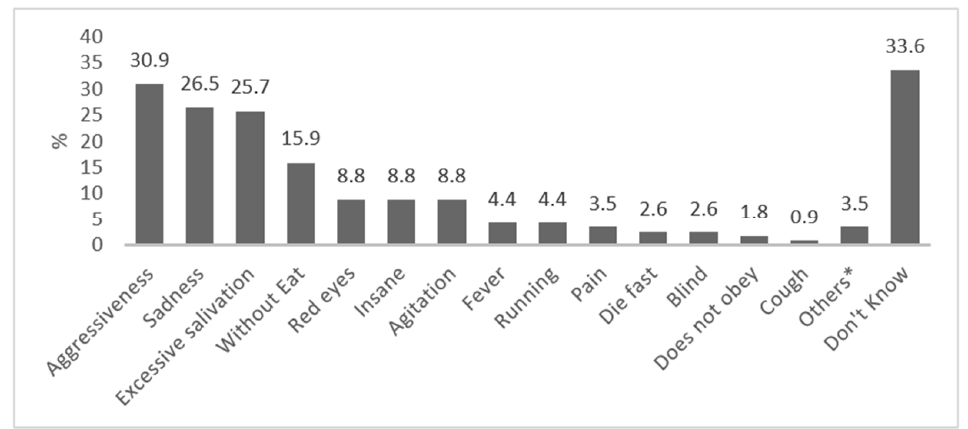
Figure 4. Symptoms of rabies, as reported by respondents. * Others: barking (0.9%), not drinking sufficiently (0.9%), stiff tail (0.9%), quivering (0.9%). Almost 64% answered animal vaccination as a form of prevention, followed by 20% who stated avoidance of contact with wild animals. Other answers that are not adequate measures of rabies prevention included: medication, not stressing the animals and taking care of the animals’ food, water and hygiene (Figure 5).